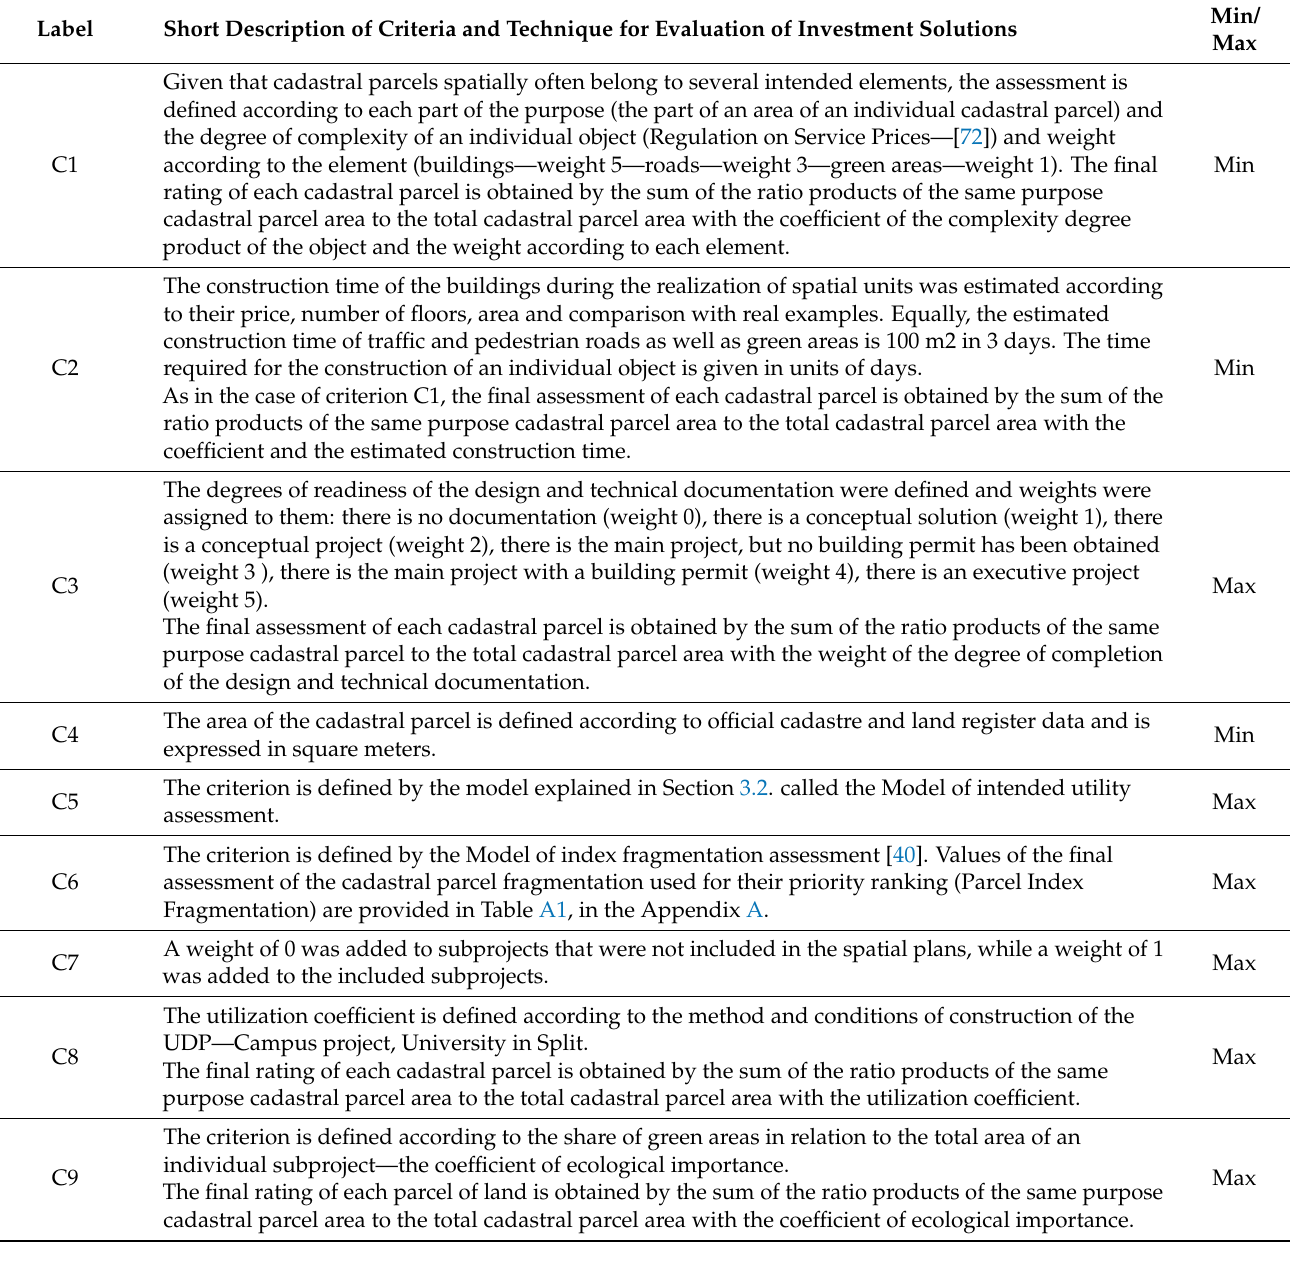
Table 2. Criteria description and technique for